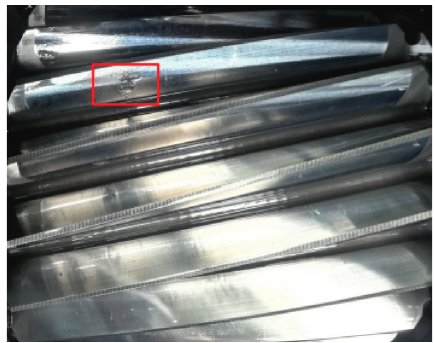
Figure 15: Fault location occurring on the small